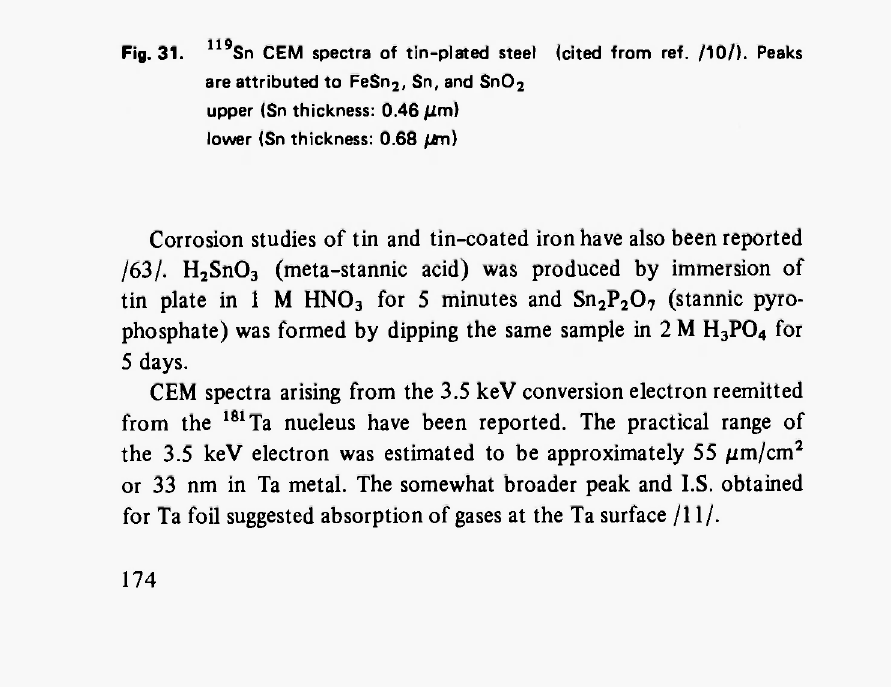
Fig. 31. 119 Sn CEM spectra of tin-plated steel (cited from ref. /10/). Peaks are attributed to FeSn 2 , Sn, and Sn0 2 upper (Sn thickness: 0.46 /im) lower (Sn thickness: 0.68